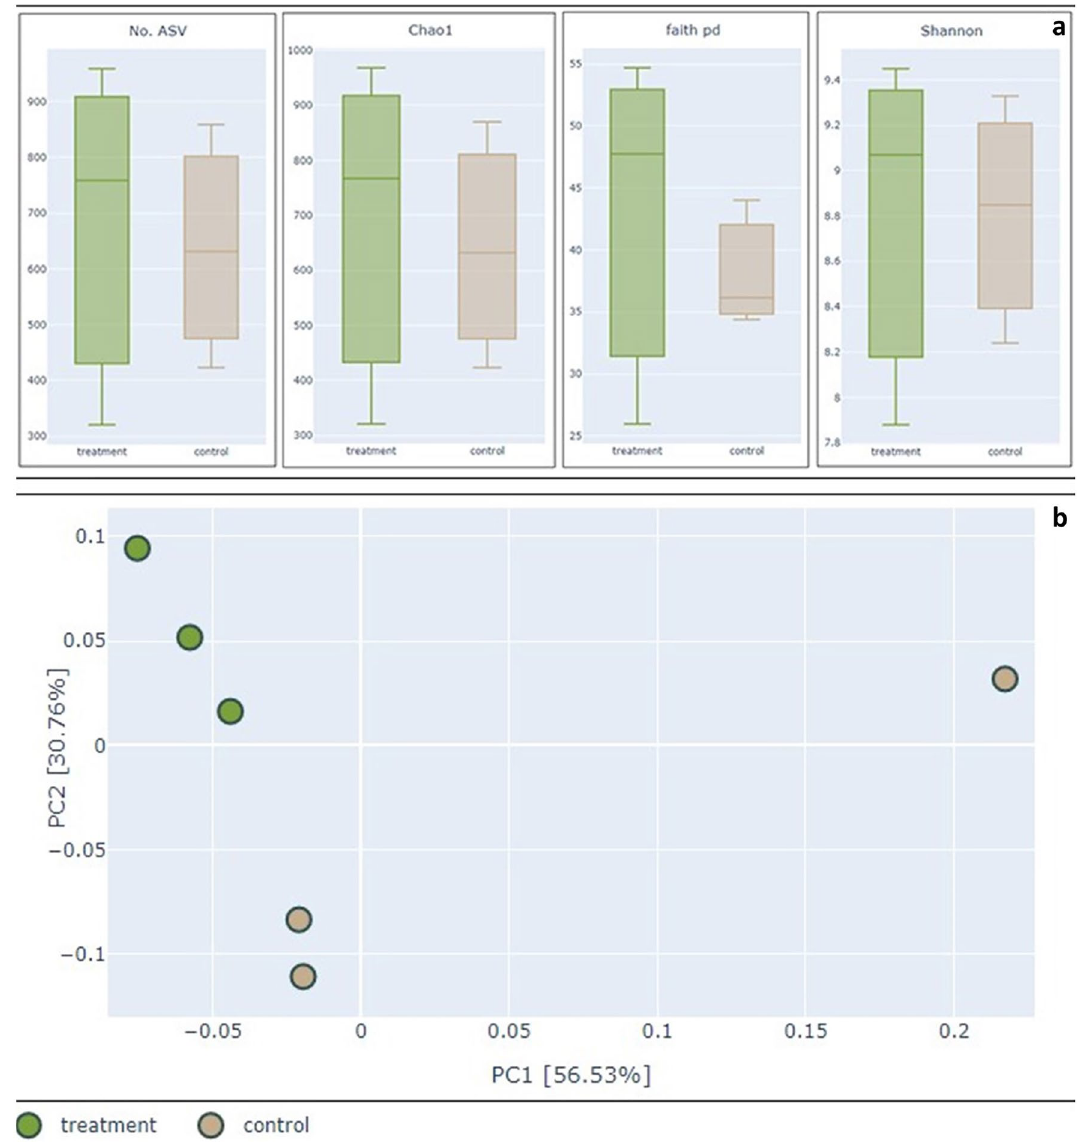
Figure 1. ( a ) Boxplots of alpha diversity index including number of ASVs, Chao1 richness estimator, Faith’s phylogenetic diversity, and Shannon diversity index. ( b ) Principal coordinate analysis (PCoA) from the Bray– Curtis distant